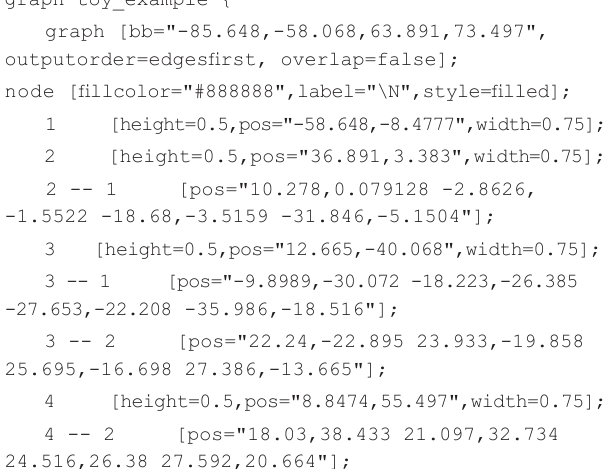
Figure 13. The DOT network as it looks in Cytoscape.